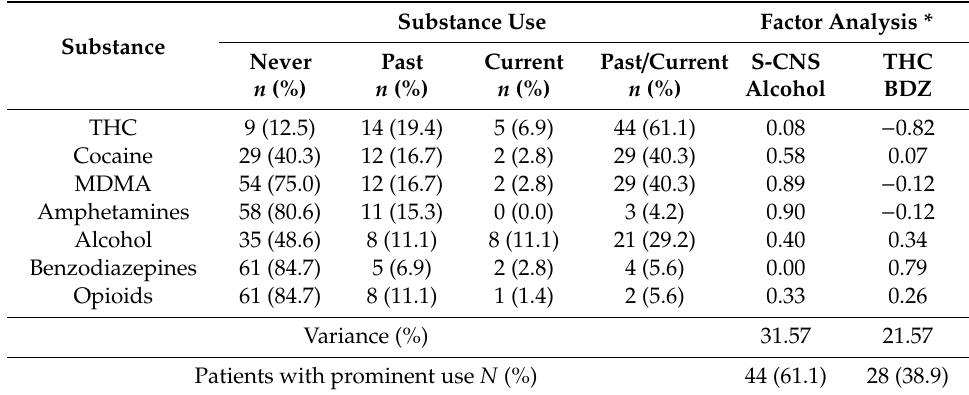
Table 1. Past and current substance use in adults with Attention-Deficit / Hyperactivity Disorder (A-ADHD) with Substance Use Disorders (SUDs). Substance Use Factor Analysis Substance